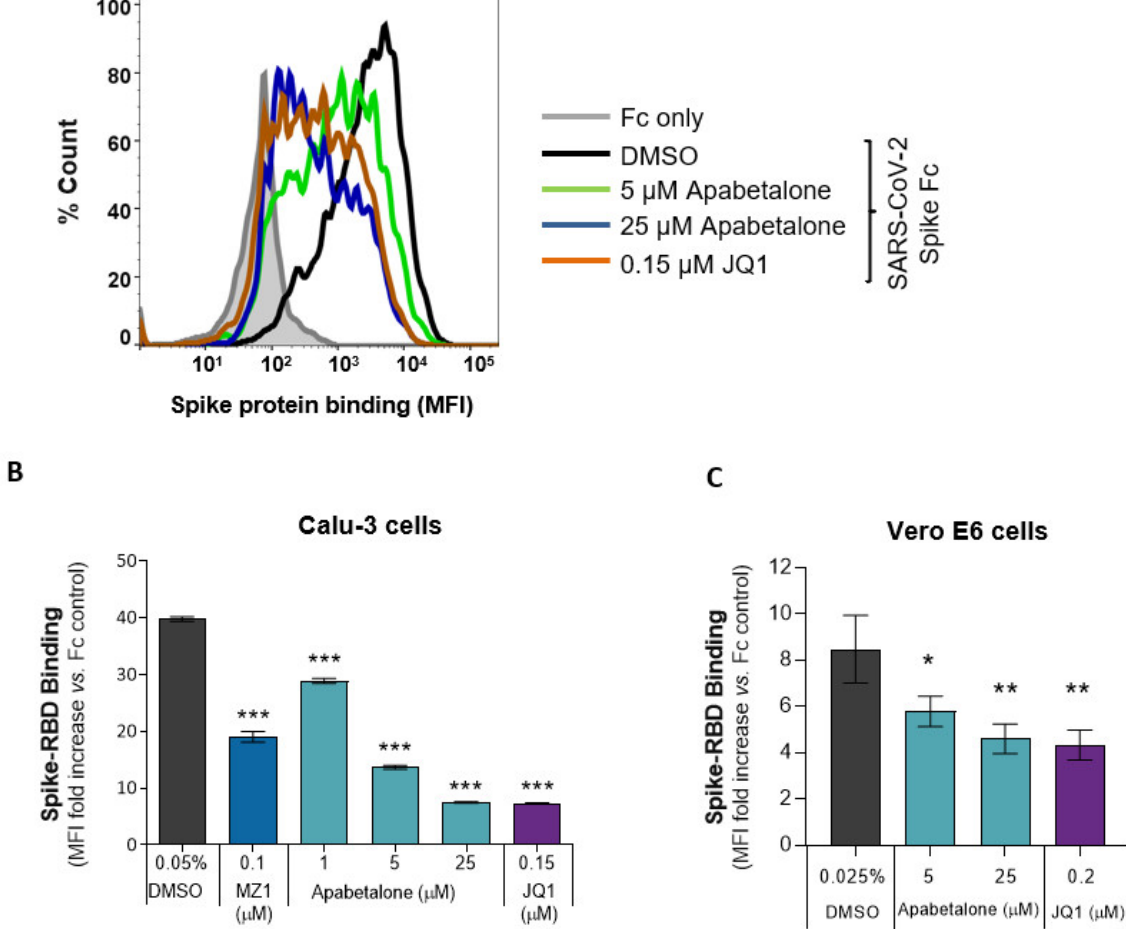
Figure 3. BET inhibition decreased SARS-CoV-2 spike RBD binding to Calu-3 and Vero E6. ( A ) A histogram overlay representing the binding of SARS-CoV-2 spike RBD Fc fusion protein to Calu-3 following 48 h of apabetalone or JQ1 treatment at the indicated concentrations. ( B , C ) Quantification of BETi-driven changes to SARS-CoV-2 spike RBD binding to Calu-3 ( B ; n = 3) or Vero E6 ( C ; n = 3) cells following 48 h of treatment. Binding results are shown as mean fluorescent intensity (MFI) ratio to Fc control. Error bars represent SD. * p < 0.05, ** p < 0.01, *** p < 0.001, one-way ANOVA followed by Dunnett’s multiple comparison